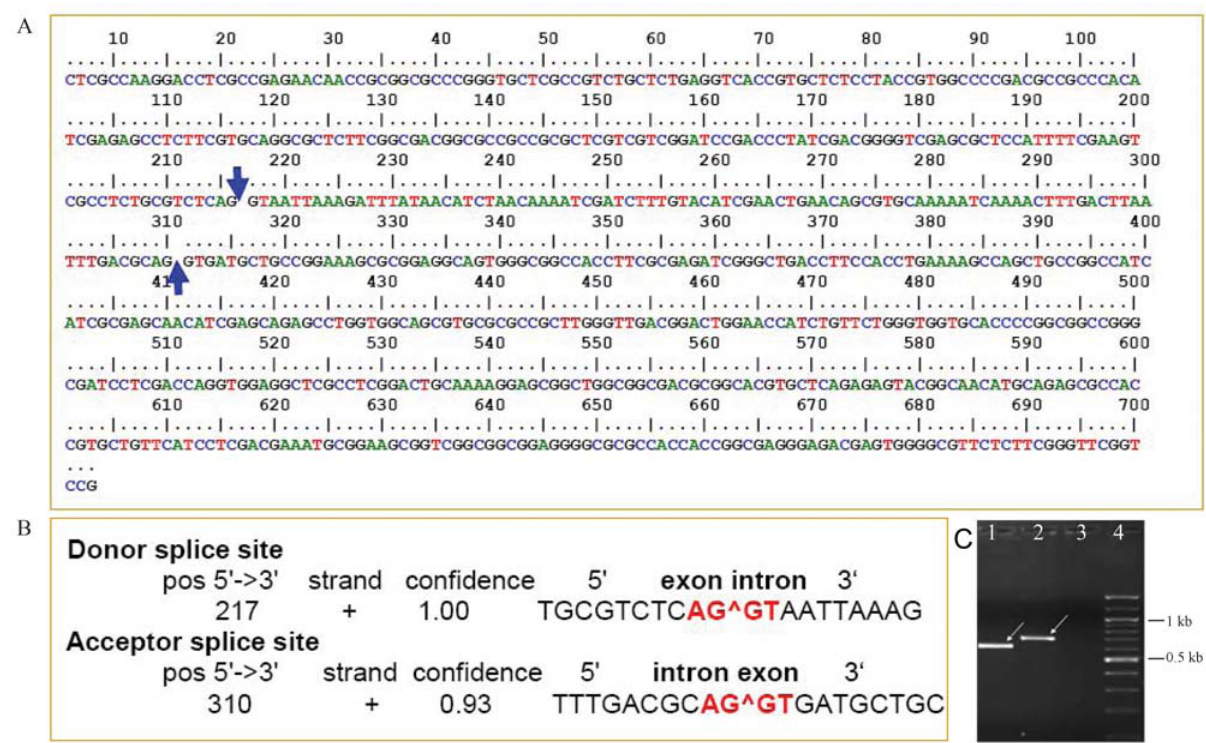
Figure 1 - A. Intron prediction for the Alpinia calcarata PKS sequence carried out at the NetPlantGene web server. The arrows represent putative splice sites. B. A donor splice site predicted at 217 bp and an acceptor splice at the 310 bp position. C. Amplification of a core fragment of the Alpinia